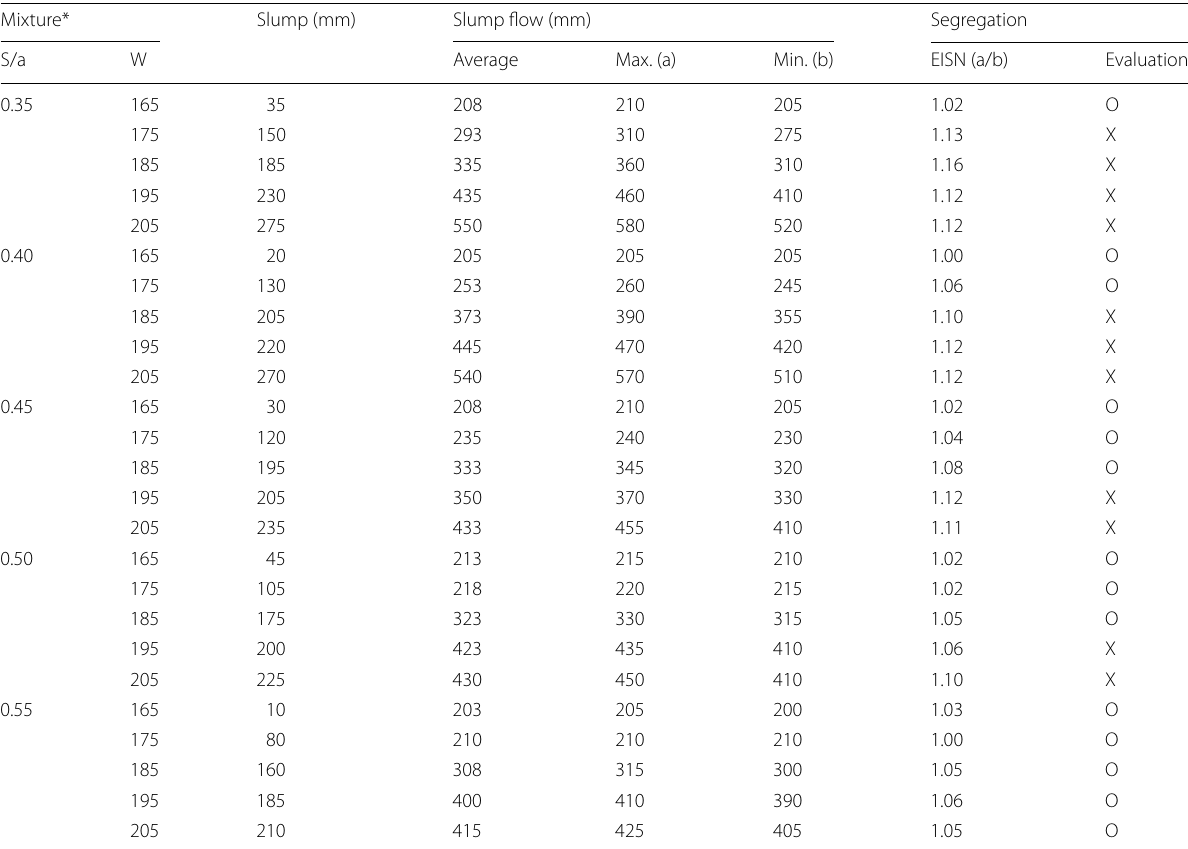
Table 4 Slump and slump flow test results and EISN calculation data of normal concrete